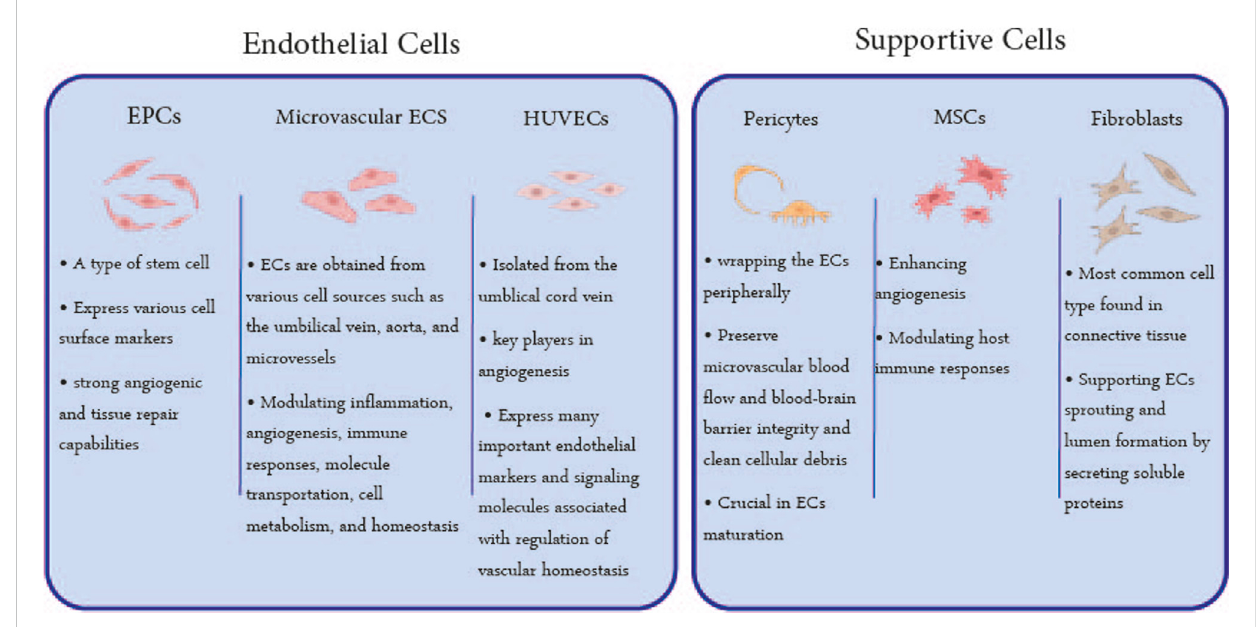
FIGURE 4 Utilized Cell Types in Re-endothelialization: The cells utilized in the endothelialization of acellular scaffolds can be classi fi ed into two general categories: ECs and supporting cells. EPCs, microvascular ECs, and HUVECs are the most used ECs, and MSCs, pericytes, and fi broblasts are supporting cells whose characteristics are mentioned in this fi